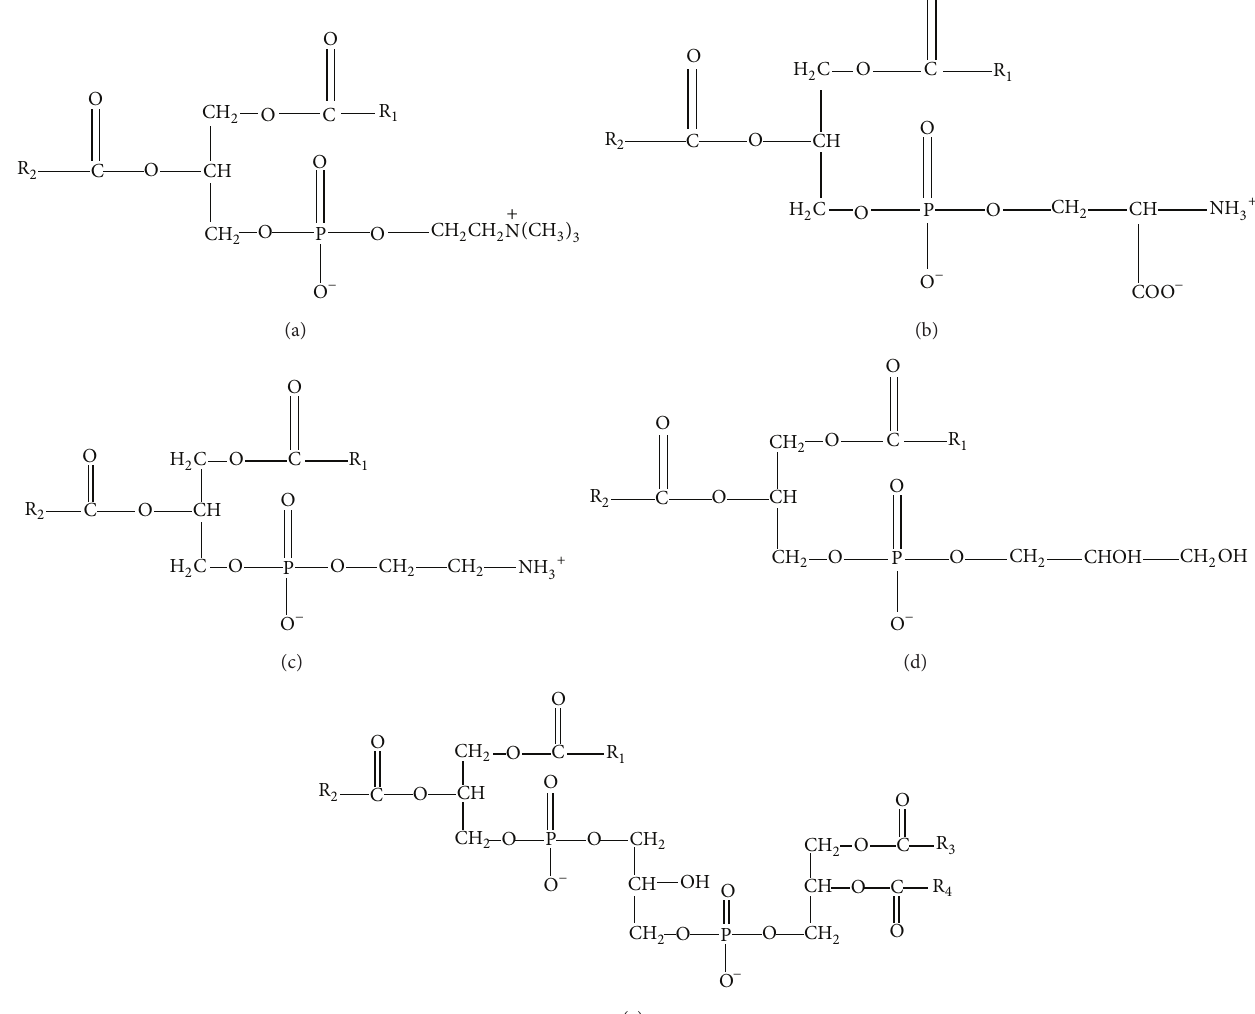
Figure 2: Structure of bacterial membrane phospholipids—phosphatidylcholine (a), phosphatidylserine (b), phosphatidylethanolamine (c), phosphatidylglycerol (d), and cardiolipin (e). R 1 , R 2 , R 3 , and R 4 represent fatty acid acyl chains.